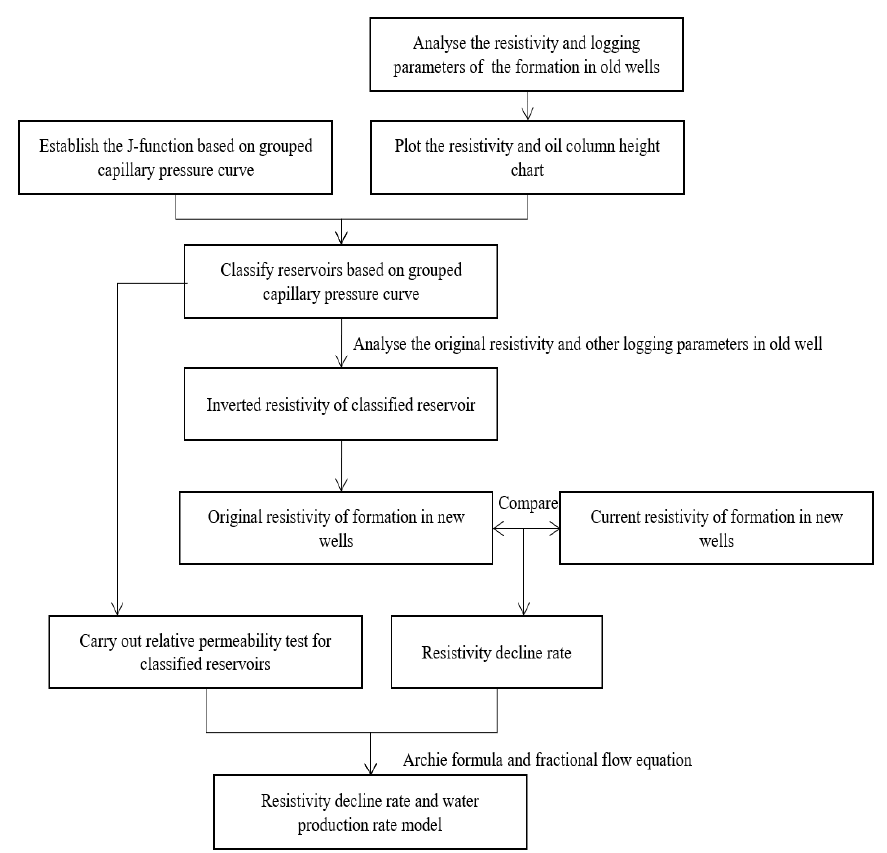
Figure 3. The quantitative evaluation process of the water-flooded zone in sandstone reservoir with complex porosity–permeability relationship.